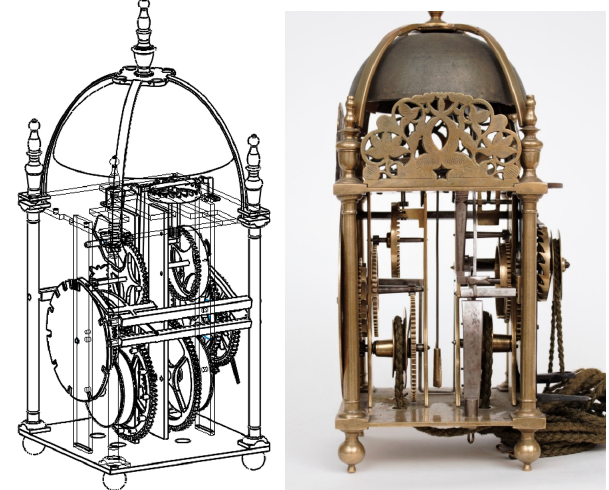
Figure 29. N11 – Lantern clock (Thomas Taylor) (Artlistings, 2022a).